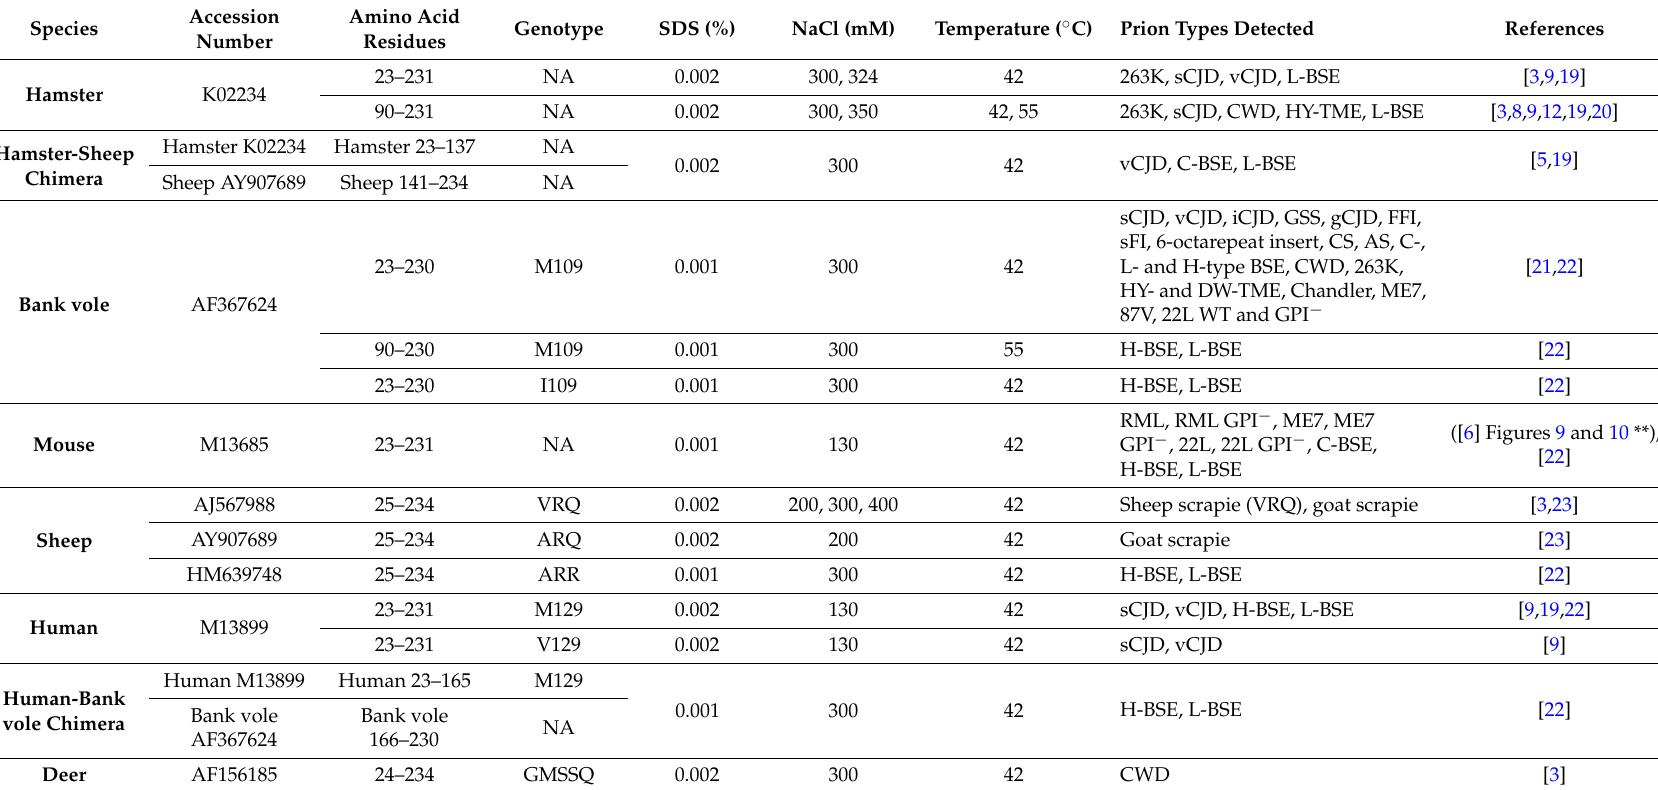
Table 1. Currently implemented RT-QuIC conditions